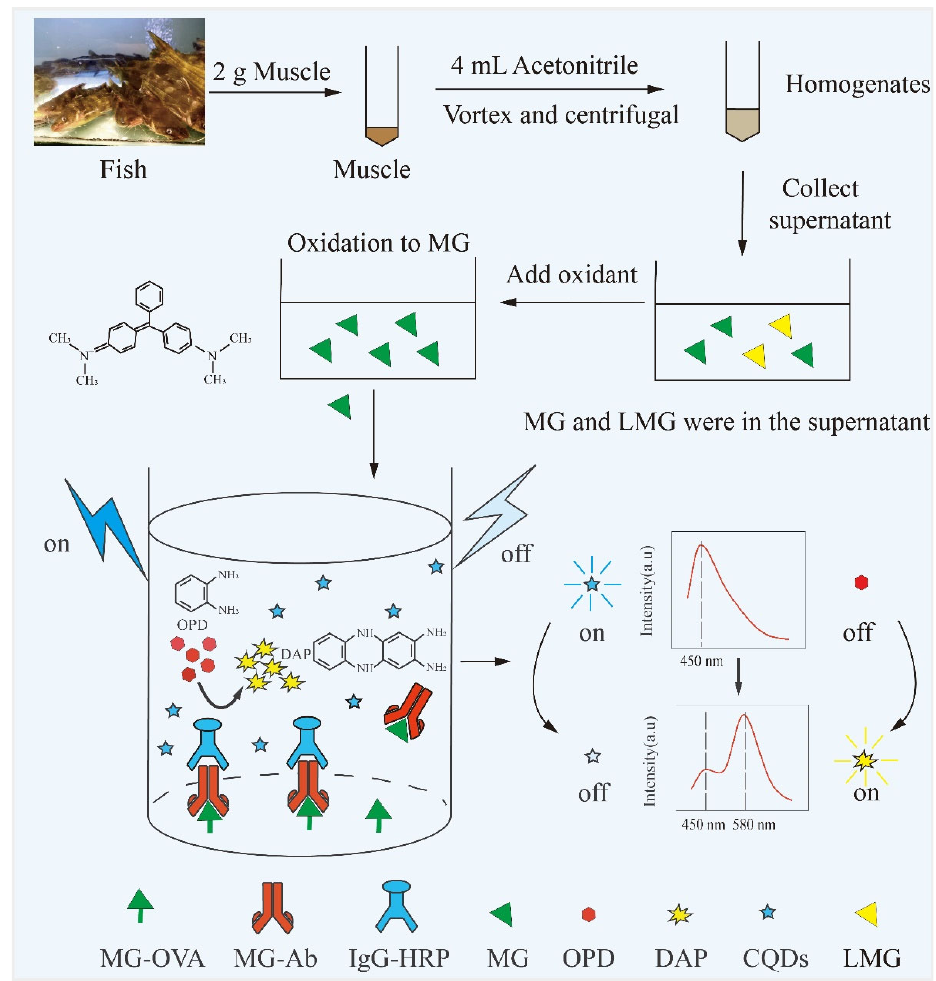
Figure 1. Schematic illustration of the ratiometric fluorescence immunoassay for MG determina ‐